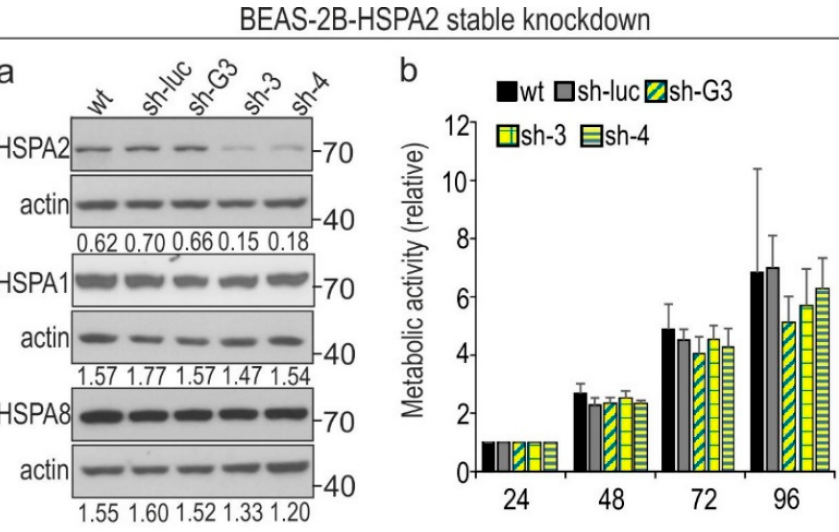
Figure 1. Heat Shock Protein A2 (HSPA2) level in wild-type cells (wt; black bars), modified control cells (sh-luc, CRISPR-ctr; gray bars), and HSPA2-deficient cells (sh-G3, sh-3, sh-4; yellow and green bars patterns, CRISPR-A2; green bar). sh-G3, sh-3, sh-4, and sh-luc cells were modified using the lentiviral vectors encoding the HSPA2 -targetting and non-targeting shRNA sequences, respectively. CRISPR-ctr and CRISPR-A2 were generated using the CRISPR/Cas9 gene editing method. ( a ) Immunoblots showing HSPA2 level in wild- type cells. Representative immunoblots are shown ( n = 3; molecular weight in kDa is indicated); actin was used as a protein loading control. Numbers below each lane represent the protein ratio normalized to the actin level. ( b ) Densitometric analysis of immunoblots (BEAS-2B, n = 4; NCI-H1299, n = 8; NCI-H23, n = 3; NCI-H358, n = 4; NCI-H520, n = 5; MCF7, n = 5; HeLa, n = 3) was performed using ImageJ Software. The relative protein level is shown after normalization to reporter protein level (actin). Statistical significance was calculated in relation to modified control using two-tailed t- test. CRISPR-A2, cells transfected with gene editing CRISPR/Cas9 (clustered regularly interspaced short palindromic repeats and CRISPR-associated protein 9) plasmids; CRISPR-ctr, control cells transfected with negative control plasmid. * p < 0.05 versus sh-luc or CRISPR-ctr cells, statistical significance was calculated using the two-tailed t -test.